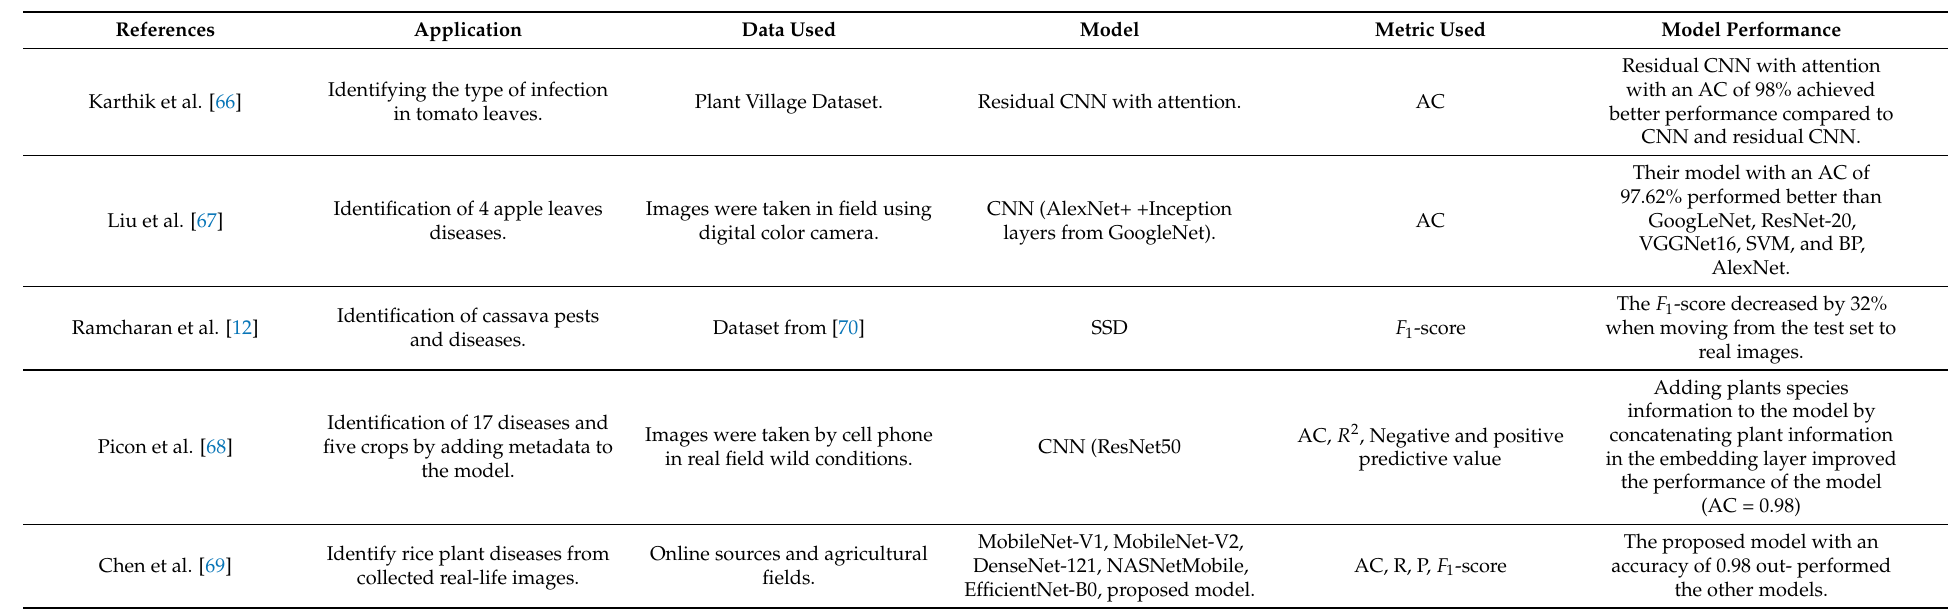
Table 2. Feature descriptions of recent published papers in the field of “Disease